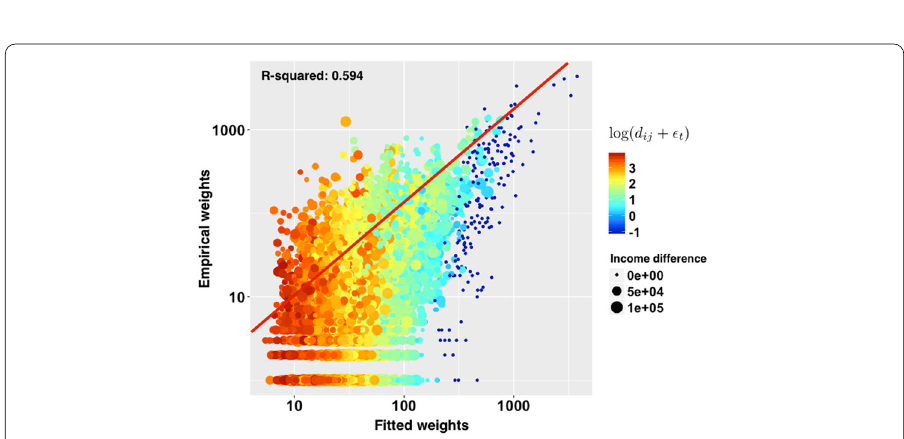
Figure 19 Weighted OLS fitting for number of mentions, for the Northern American metropolitan area